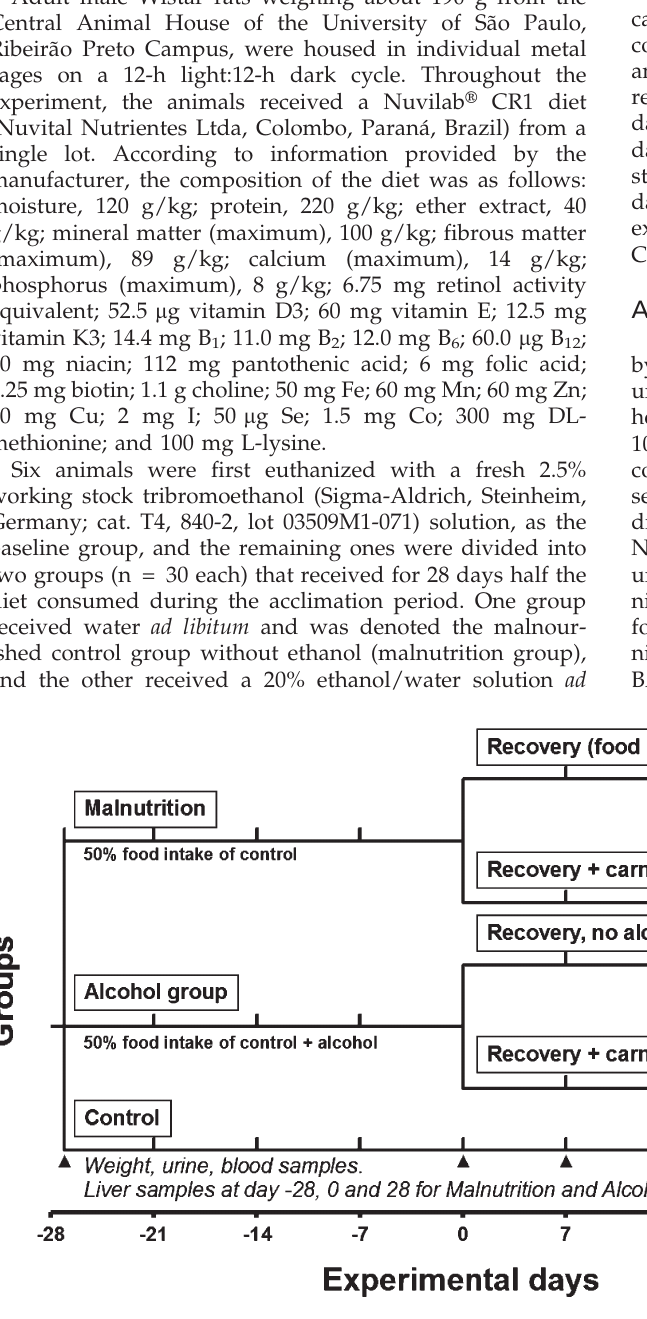
Figure 1 – Study design of the present experimental